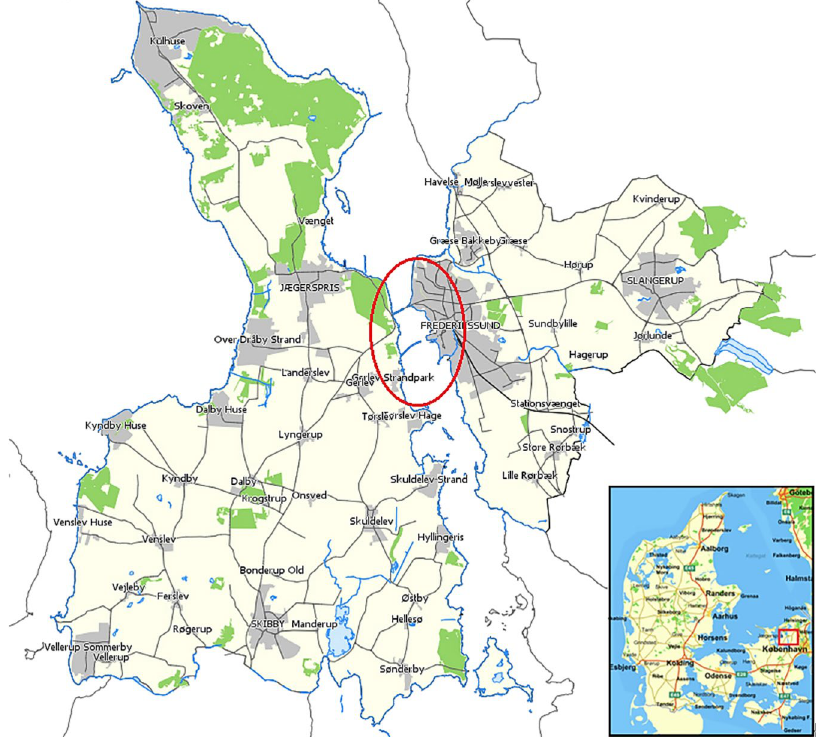
Fig. 4. Map of Frederikssund (sources: http://infokort.frederikssund.dk/borger/kort.htm ; http://www.krak.dk